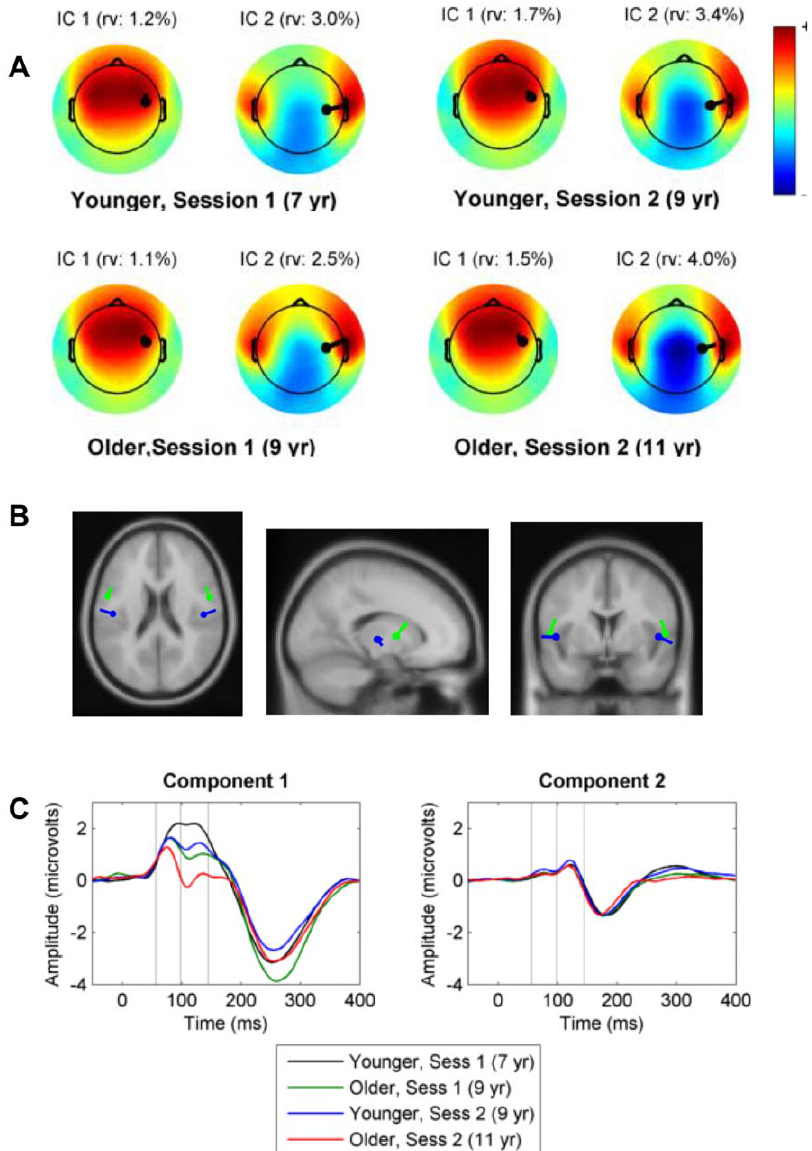
Figure 4. Characteristics of two components identified by ICA. Panel A: Scalp distribution of activity from component 1 (IC 1) and 2 (IC 2) for groups subdivided by age and session. The location of the right-sided dipole is shown in black, and its residual variance (rv) is shown above each plot. (The symmetrical left-sided dipole is not shown). Panel B: Location of dipoles for IC1 (green) and IC2 (blue), based on spherical 4-shell BESA model. Values are derived from grand mean ERP of all groups, since differences between groups were negligible. The MRI used to plot the result is the average MNI (adult) brain. Co-ordinates for dipole 1 are x=54, y=0, z=4; dipole 2: x=48, y= 2 12, z=2. Panel C: Mean component activations for IC1 and IC 2. ANOVA confirmed that, in the two windows of interest (demarcated by vertical gray lines), there were substantial age effects for IC 1, whereas age effects were non-significant for IC 2 (see text).